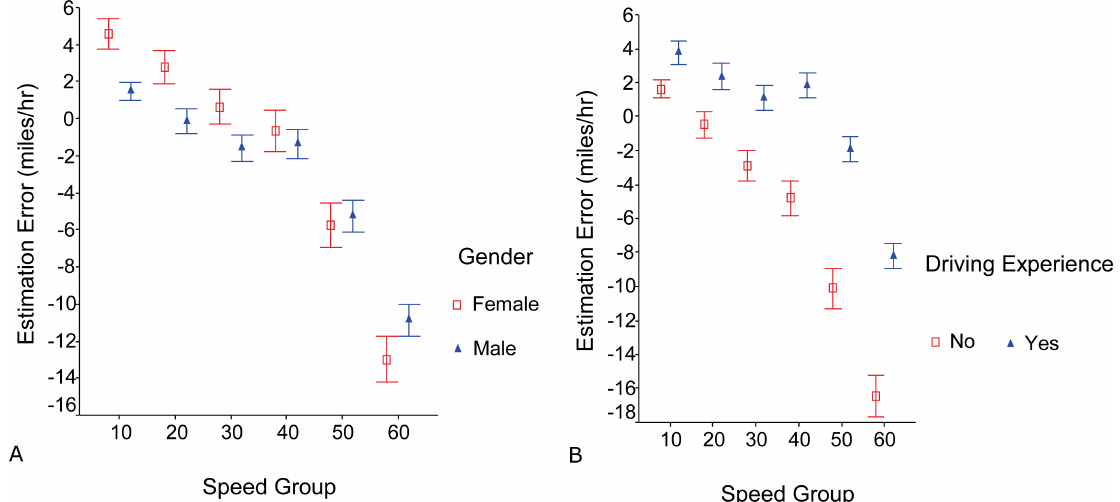
PLOS ONE | https://doi.org/10.1371/journal.pone.0185347 October 17,